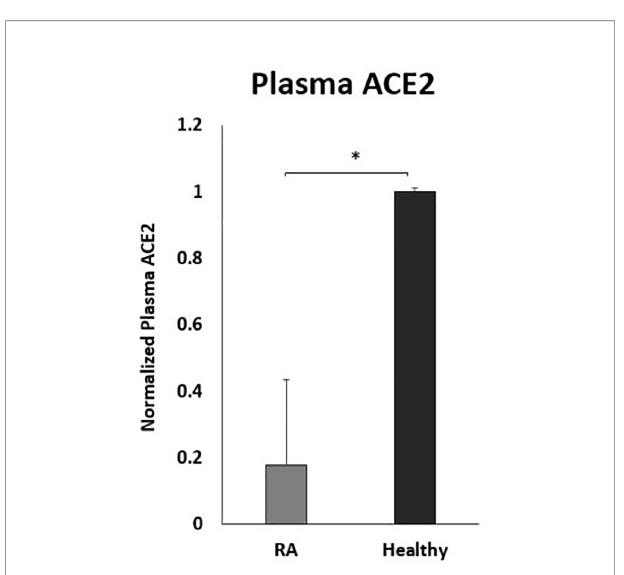
FIGURE 7 | Decreased plasma ACE2 levels in RA patients on anti- TNF- a treatments. RA patients (n=9) and healthy control (n=12). ACE2 levels were detected by ELISA. Data are shown as mean ± SD, and signi fi cance is considered as *P <